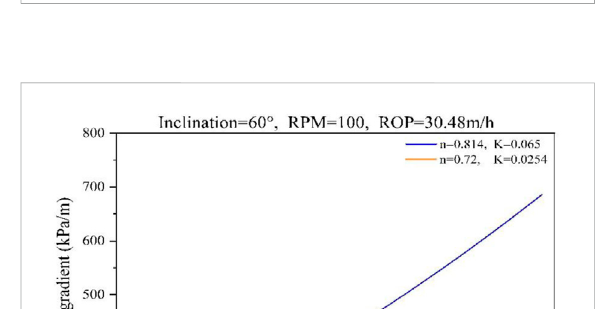
FIGURE 16 Effect of annulus geometry on pressure